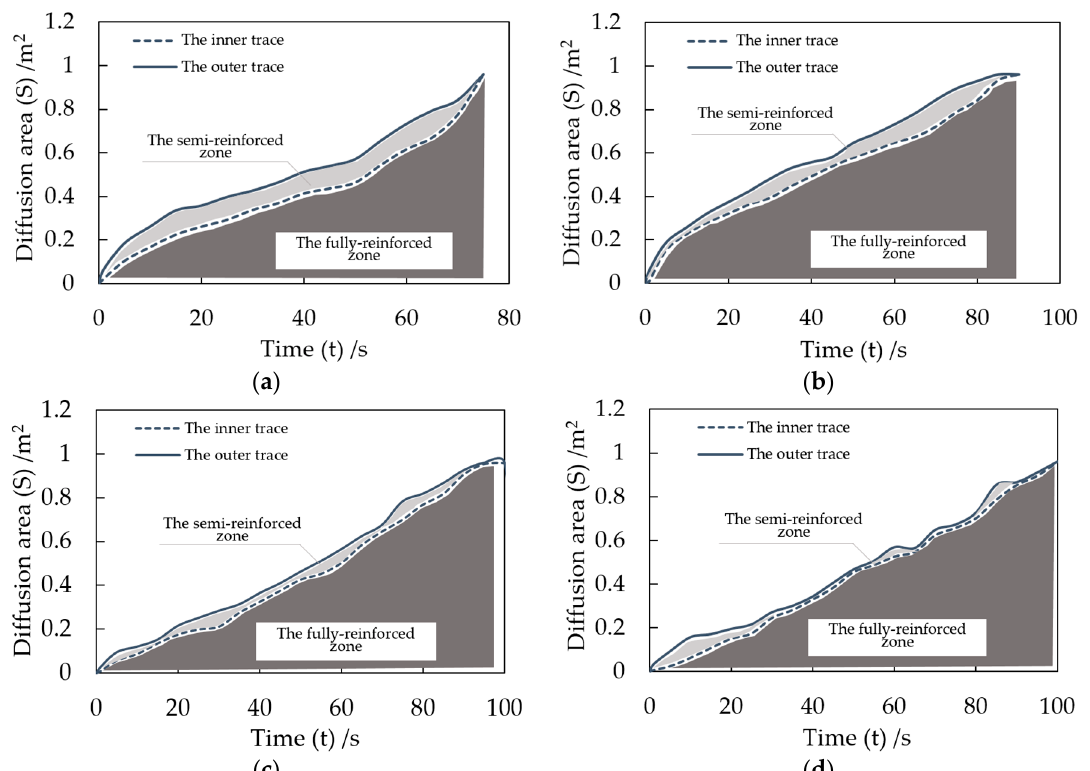
Figure 13. Grouting diffusion area under different test conditions. ( a ) No saw teeth; ( b ) R1; ( c ) R2; ( d ) R3.